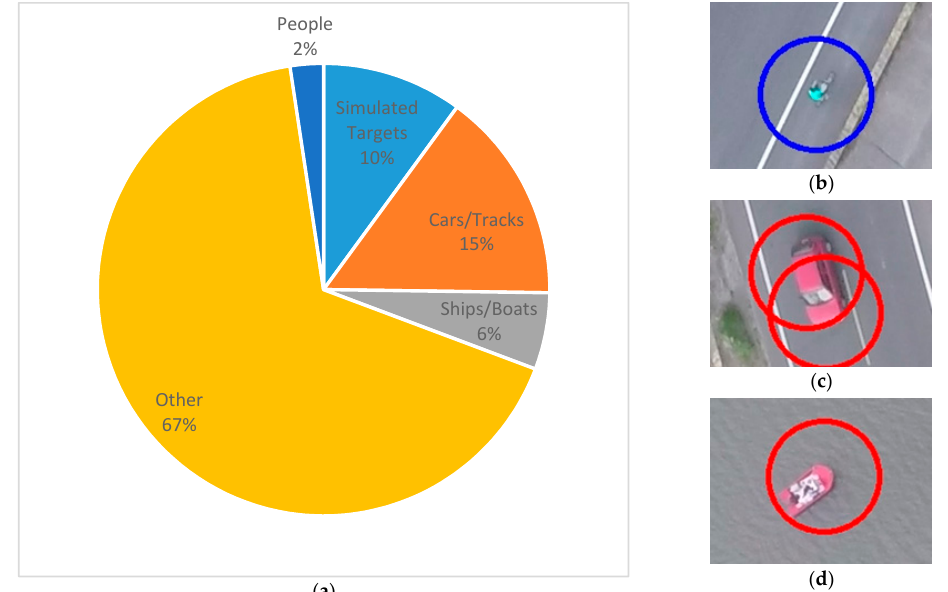
Figure 22. ( a ) Composition of reporting targets; ( b ) a person on the road; ( c ) a red car and ( d ) a red boat reported by the identification program.